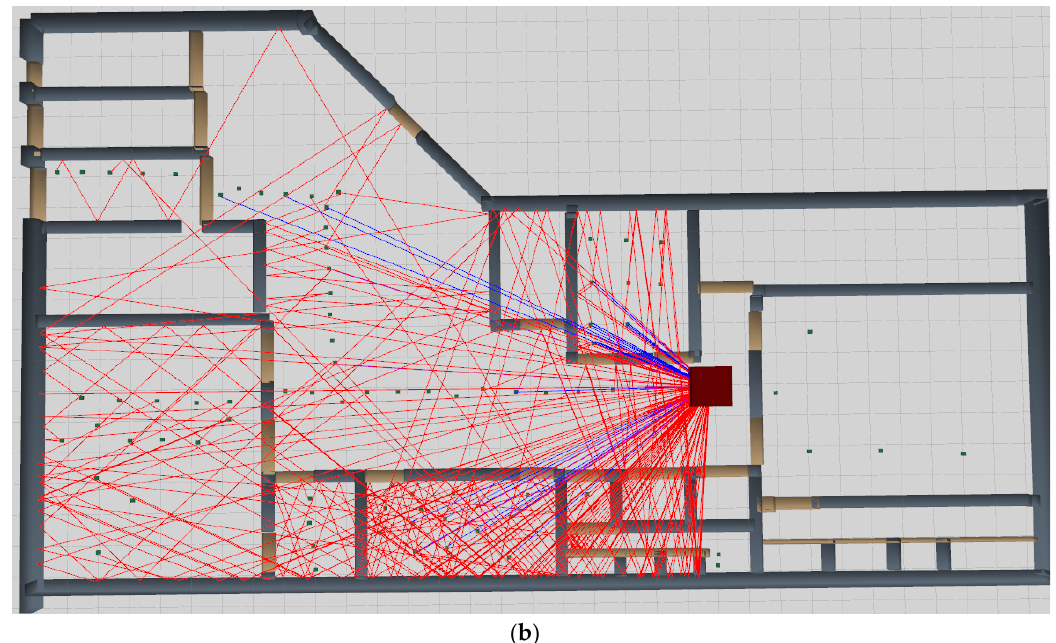
Figure 5. ( a ) 2-D and ( b ) 3-D simulation layout using the proposed method.